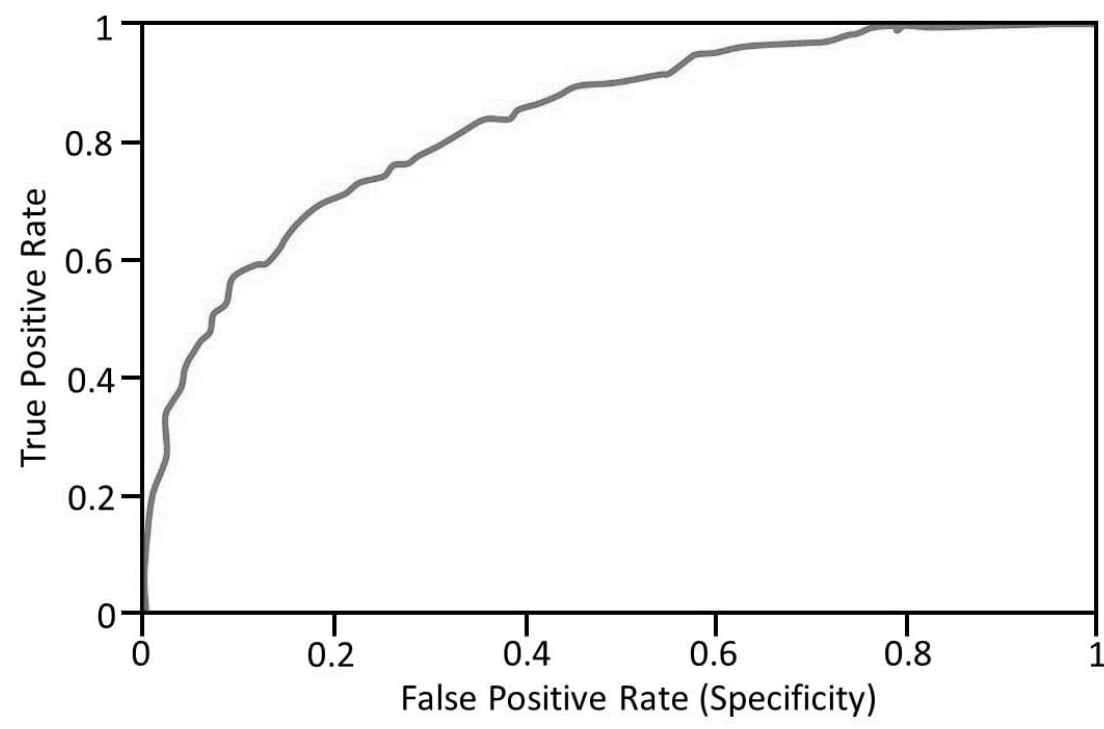
Figure 10. ROC Figure 10. ROC Curve.